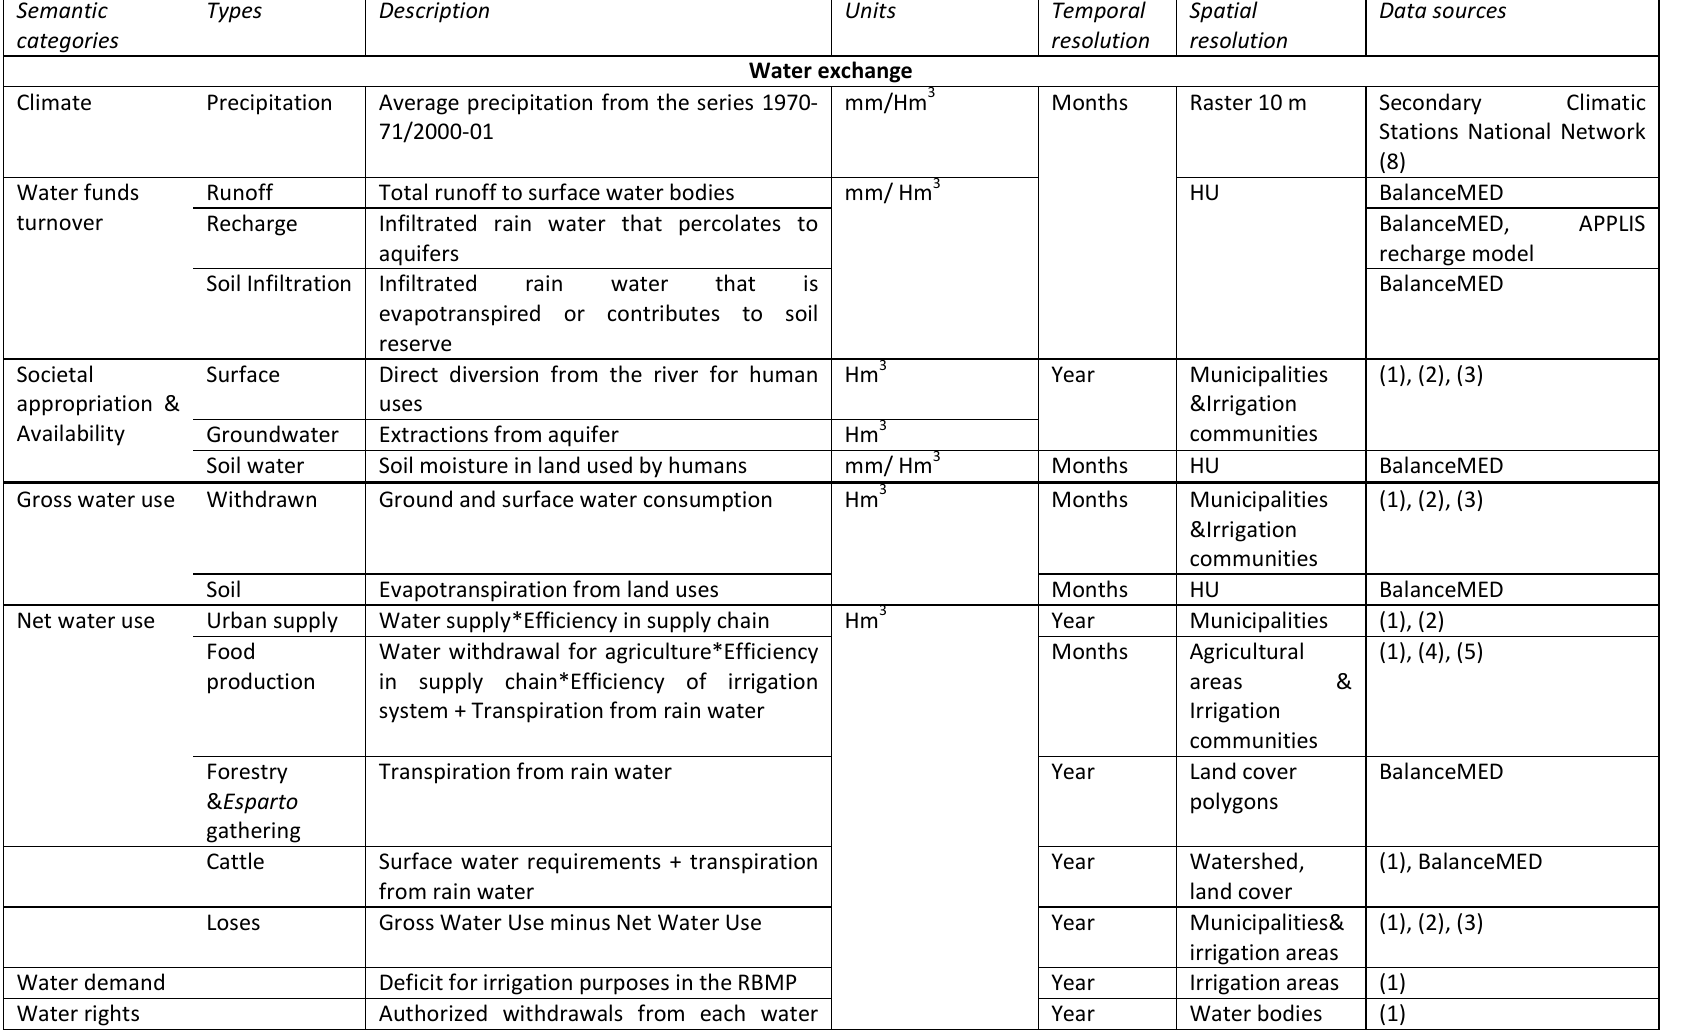
Table 1 - Formal categories of the water